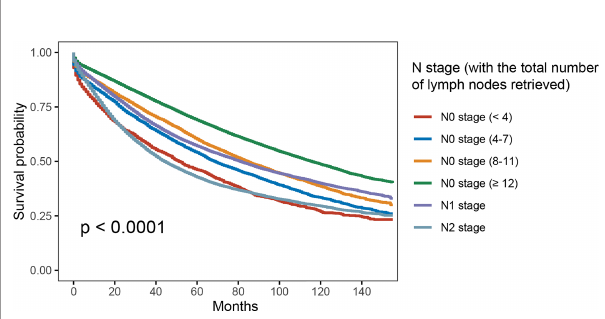
TABLE 1 | Demographics and clinical characteristics.